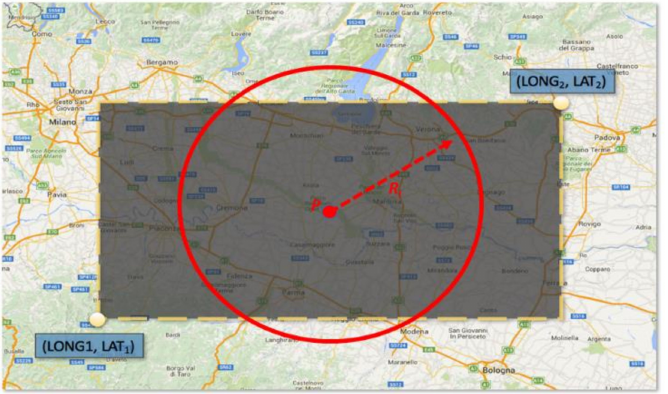
Figure 4. Example of a rectangular geographical region used by the Twitter social platform and the proposed circular interesting